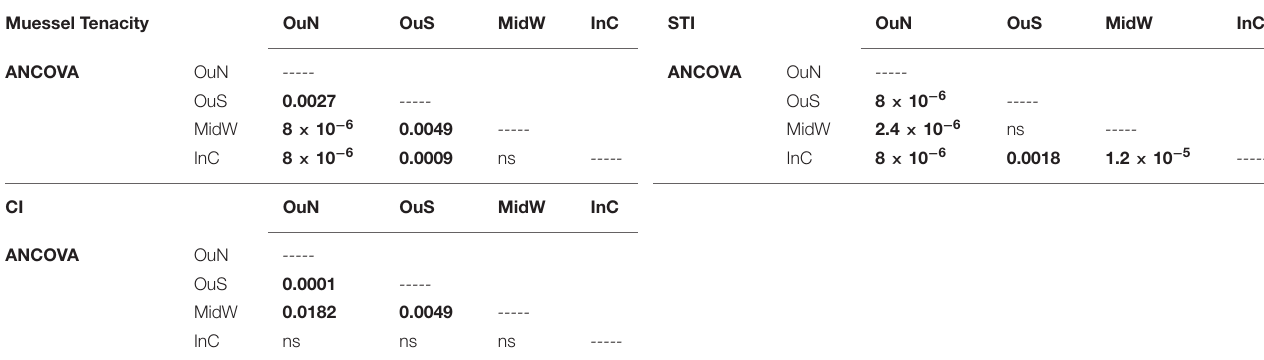
TABLE 3 | Statistical output of the statistical analyses post hoc for the four experimental localities selected for the experiment. Muessel